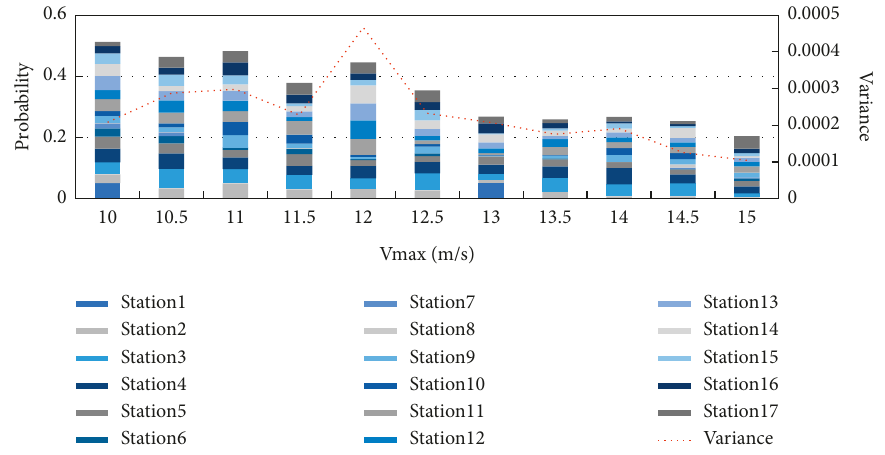
Figure 3: Probability and variance of bus headways in the bunching state for different V